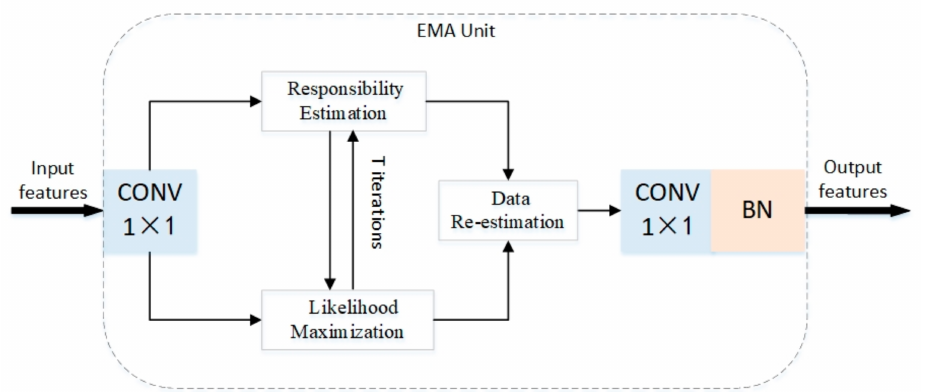
Figure 6. Structure of the expectation-maximization attention unit